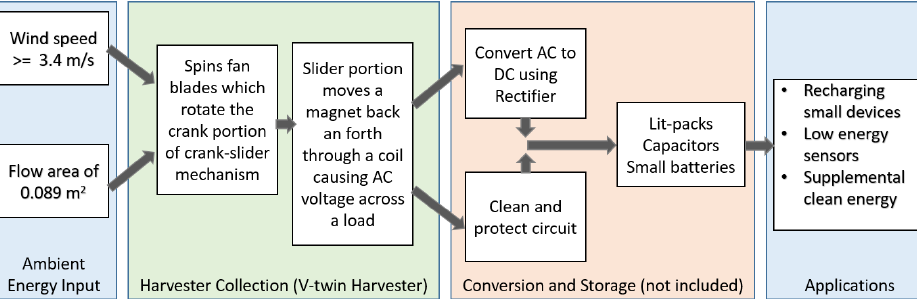
Figure 6. Schematic of wind harvesting